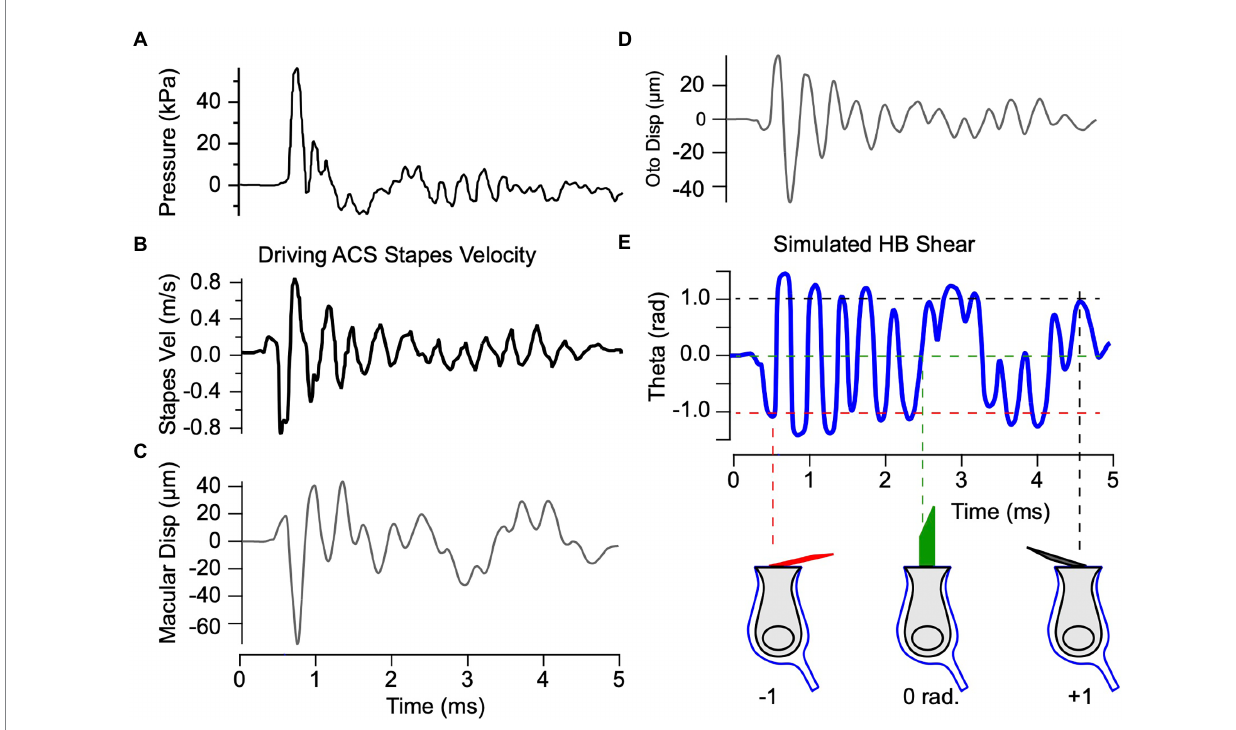
FIGURE 7 Predicted mechanical response to ACS blast waves. Model parameters are the same as previous figures. (A,B) Blast induced pressure and stapes velocity based on measurements from Jiang et al. (32). (C,D) Simulated displacement of the epithelial and otoconial layers in response to the experimentally measured stapes velocity in panel B . (E) Simulated shear acting to deflect hair bundles, predicting saturating deflections of hair bundles that would be expected to immediately destroy physiological